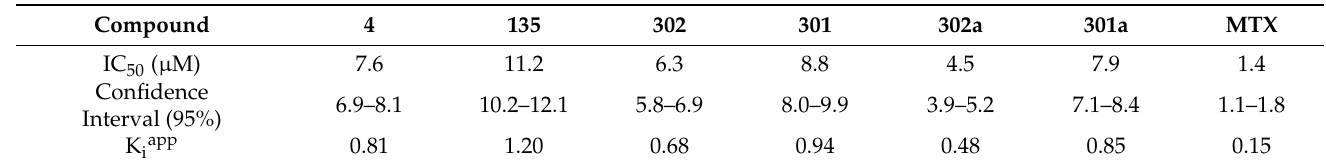
Table 1. Results of enzymatic activity against L. major dihydrofolate reductase ( Lm DHFR) for selected kaurane-type